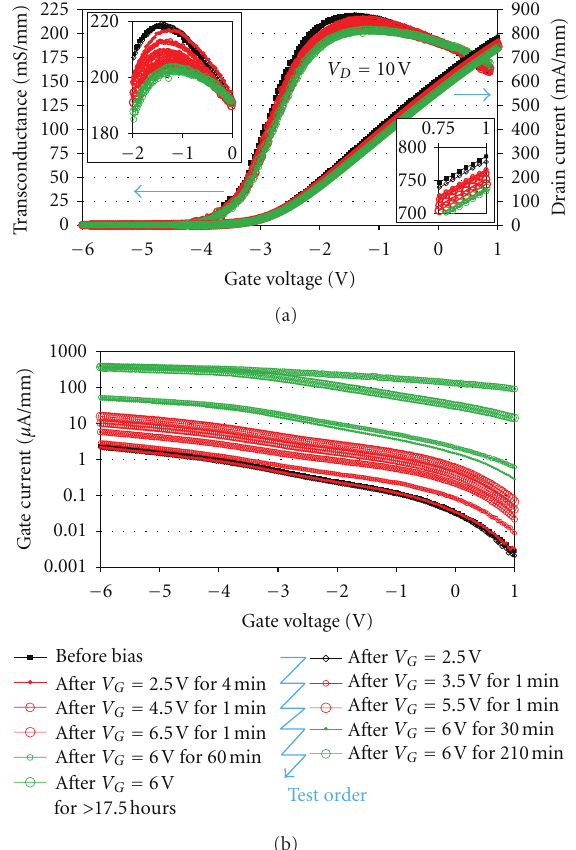
Figure 1: Transfer and transconductance curves (a) and associated gate current in absolute value (b) of the device as measured during characterizations between gate stressing events. Insets show detail at regions of interest in the same data sets. Extra gate current is seen in (b) above V G ≈ − 3 . 5 V after 210-minute stress (top curve) that is not seen after longer stress time (second-to-top curve). It is not known if there was a temporary test issue or if that is indeed real.